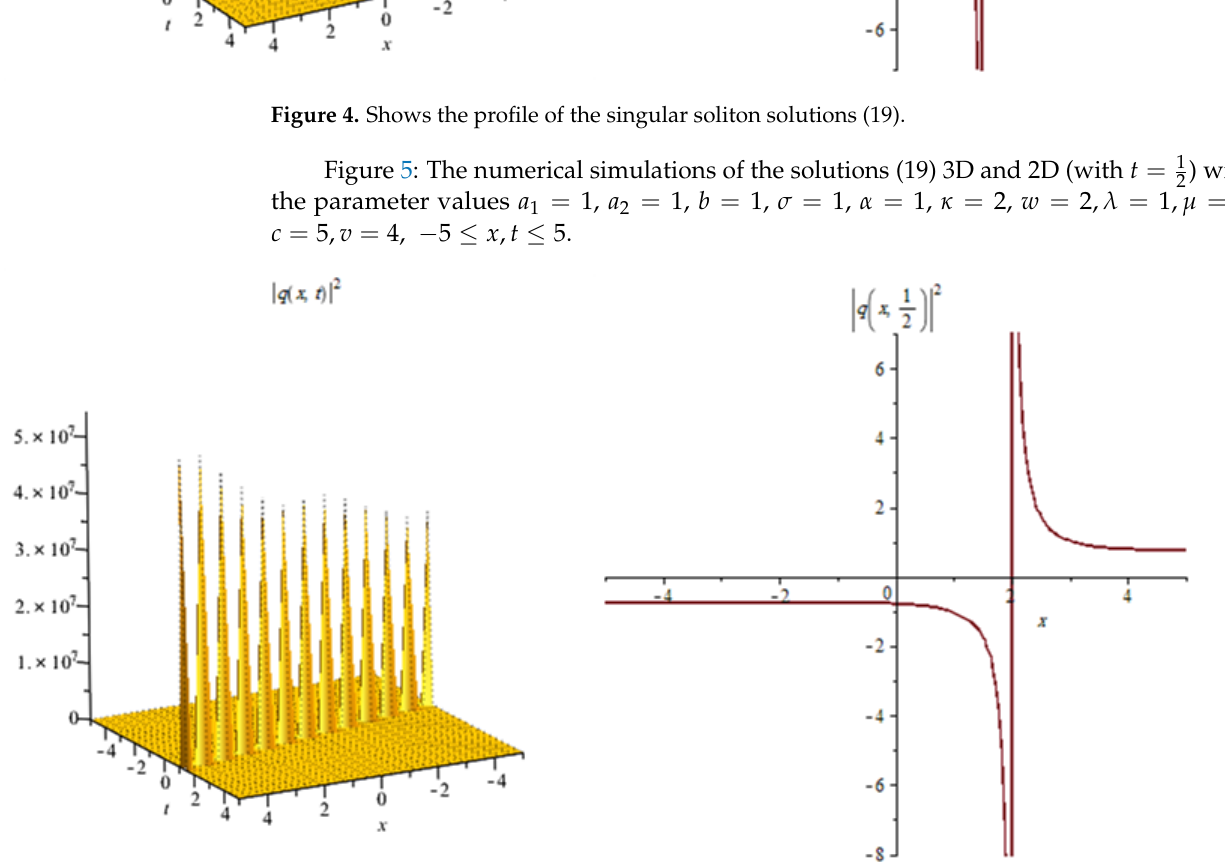
Figure 5. Shows the profile of the singular soliton solutions (19). Figure 6: The numerical simulations of the solutions (19) 3D and 2D (with t = 1 the parameter values a 1 = 1, a 2 = 1, b = 1, σ = 2, α = 1, κ = 2, w = 2, λ = 1, µ = 1, 5 c = 5, v = 8, x , t − ≤ ≤